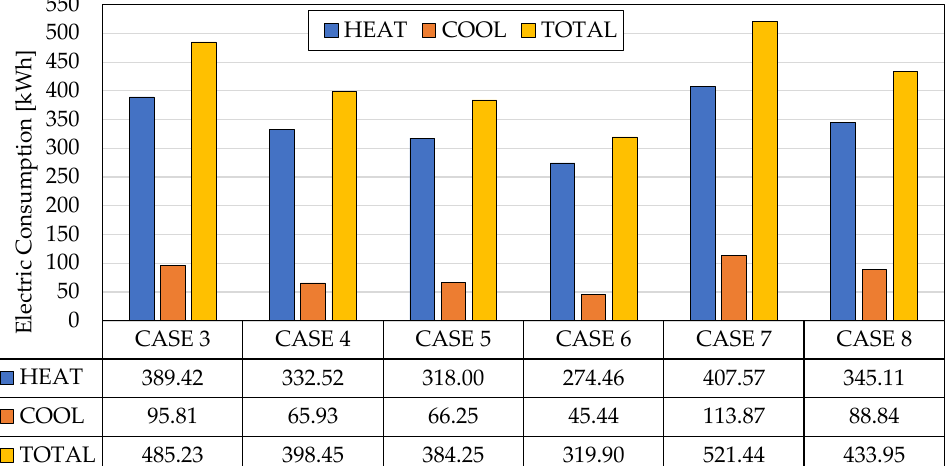
Figure 19. Annual electricity consumption of the split system among the considered cases.